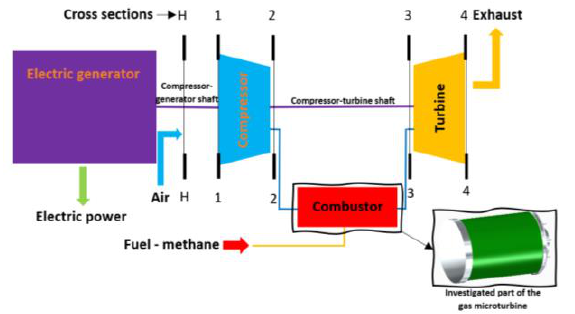
Fig. 1. The cross sections available for the analysed gas microturbine